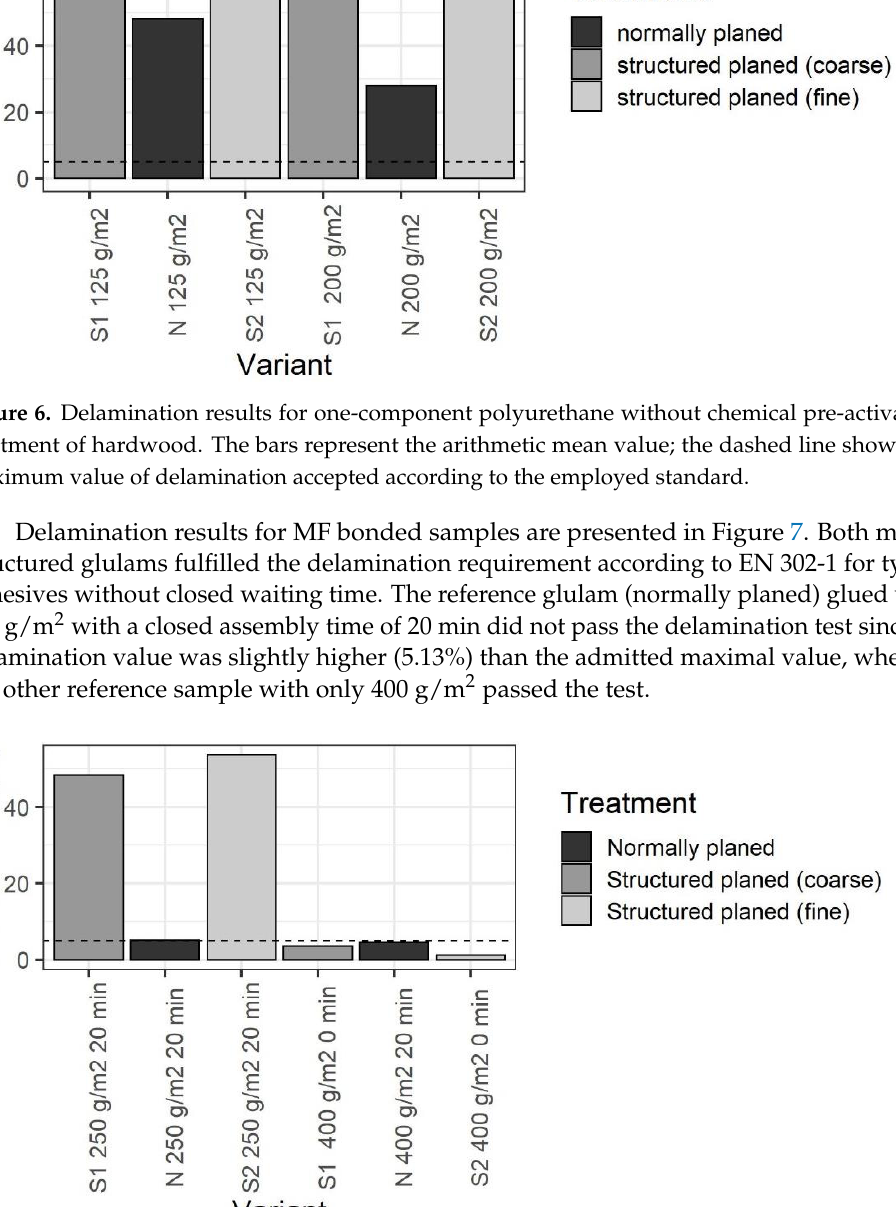
Figure 7. Delamination results for specimens bonded with MF. The bars represent the arithmetic mean value; the dashed line shows the maximum value of delamination accepted according to the employed standard.